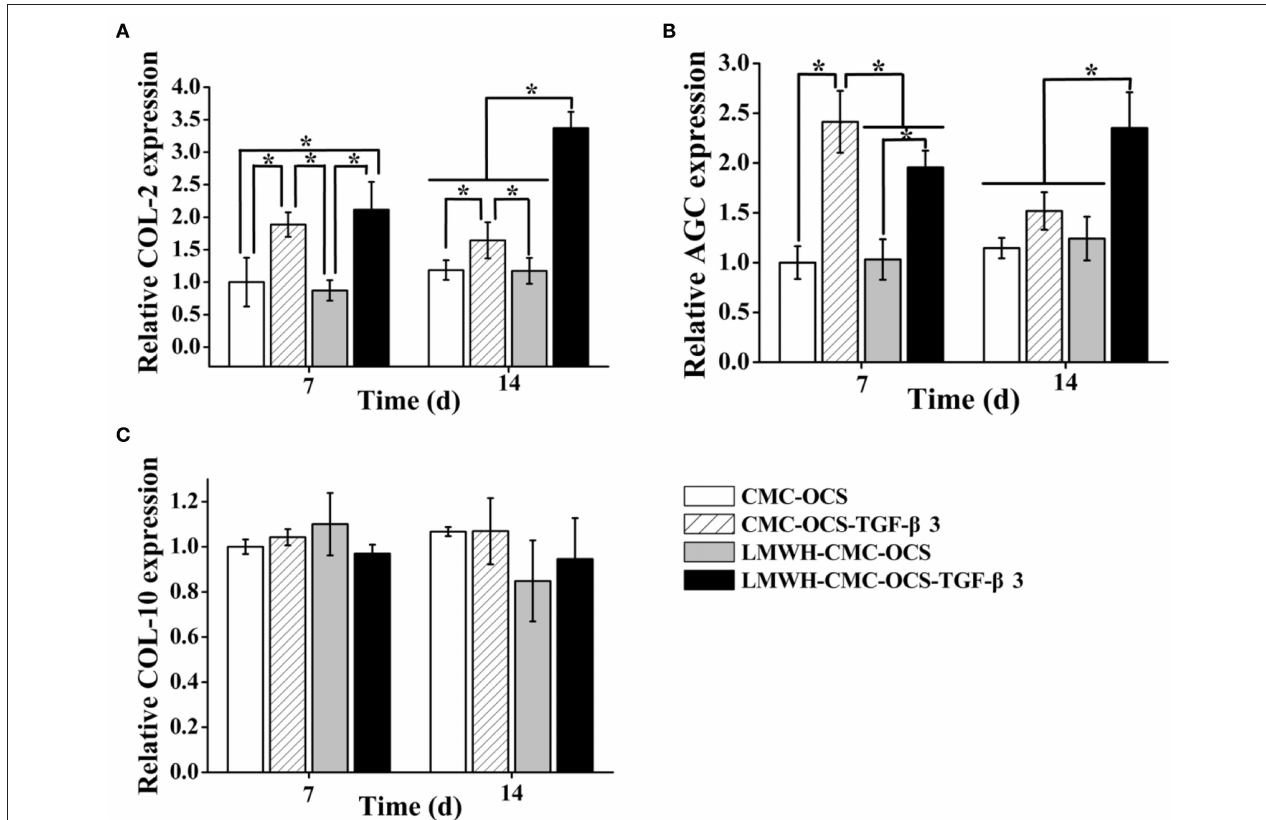
FIGURE 7 | (A) Expression of cartilage-specific genes COL-2 and (B) AGC ( n = 3, * P < 0.05). (C) Expression of hypertrophic gene COL-10.